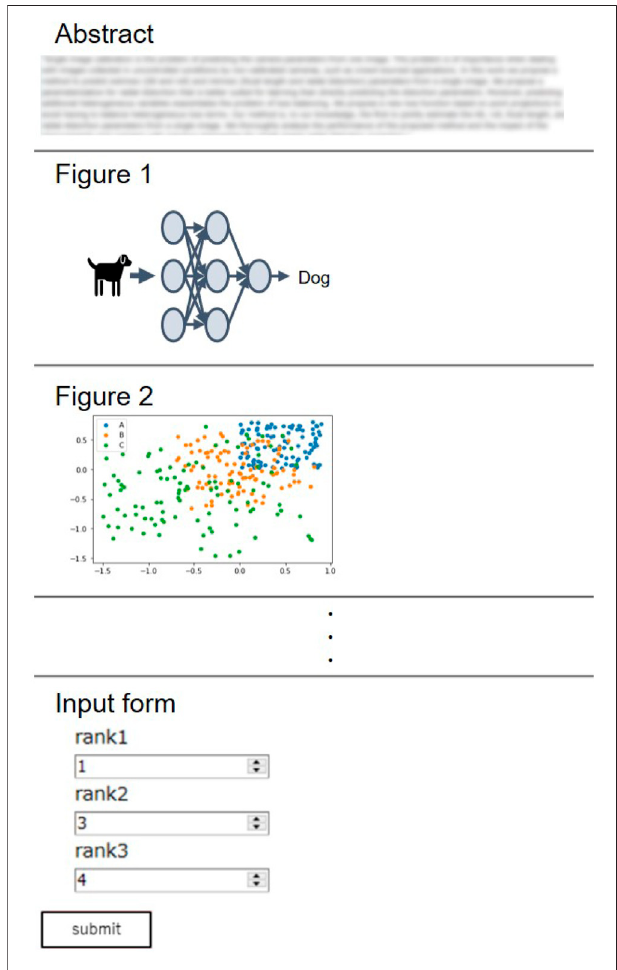
FIGURE 2 | Graphical user interface for annotation. Paper abstract is displayed at the top to provide the overview of the research. Figures are then showninrandomlyshuf fl edorder.Annotatorsareaskedto fi ll fi gurenumberof topthree fi gures thatre fl ectthecontentofabstract intheinputform. The answer is recorded after clicking a “ submit button ”